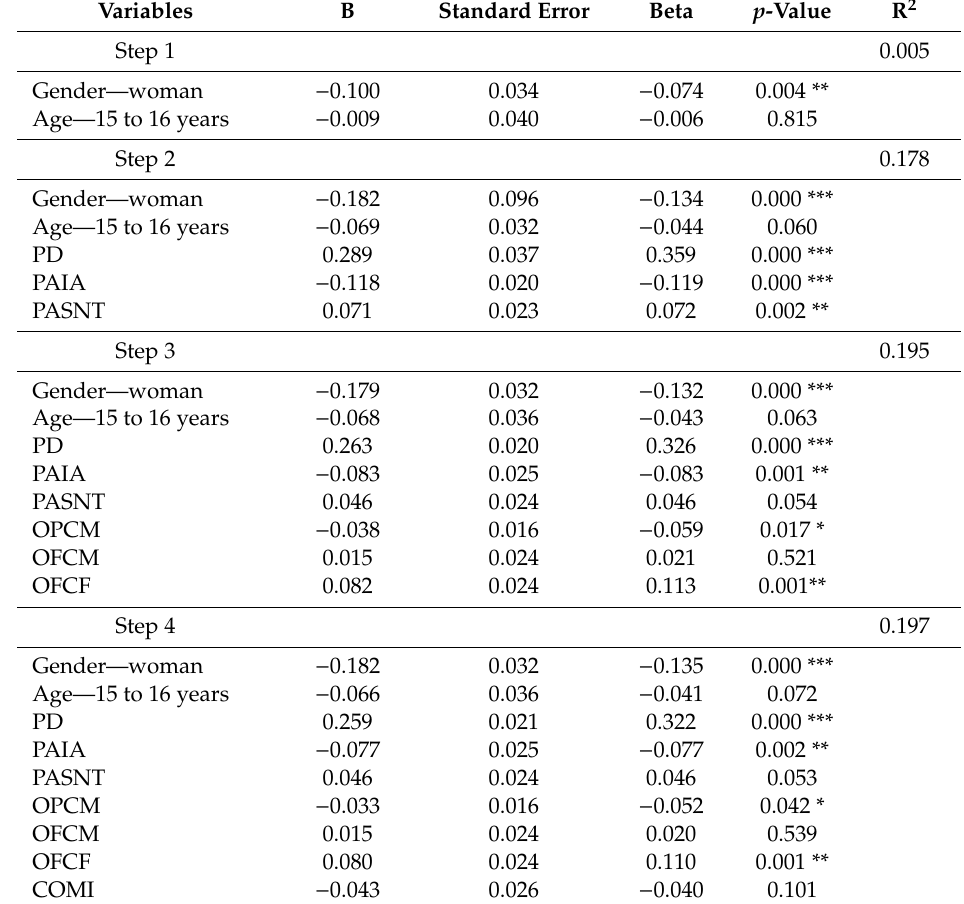
Table 5. Linear Regression